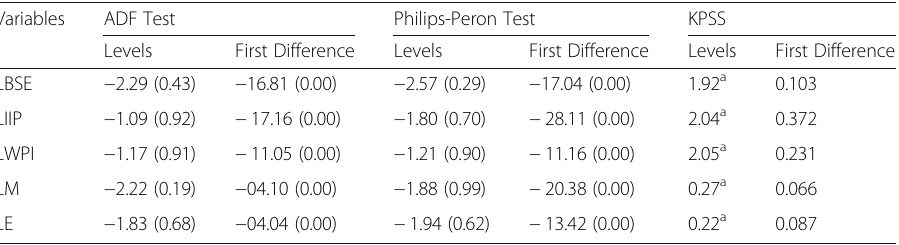
Table 1 Unit Root Test